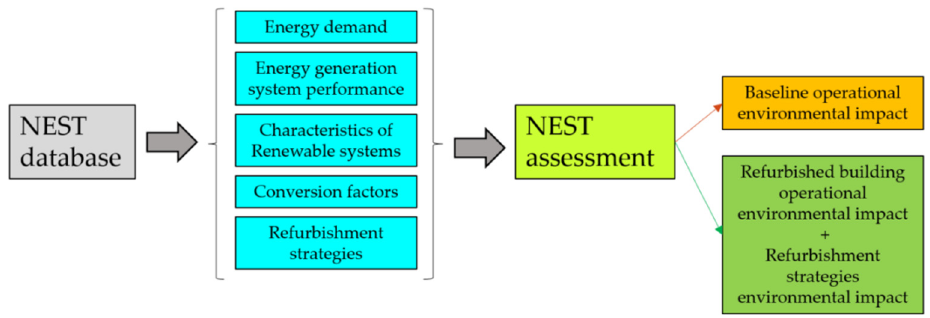
Figure A1. Diagram of the environmental assessment calculation processes of buildings in NEST. Procedure of graphic tool NEST-Sketchup (Figure A2).